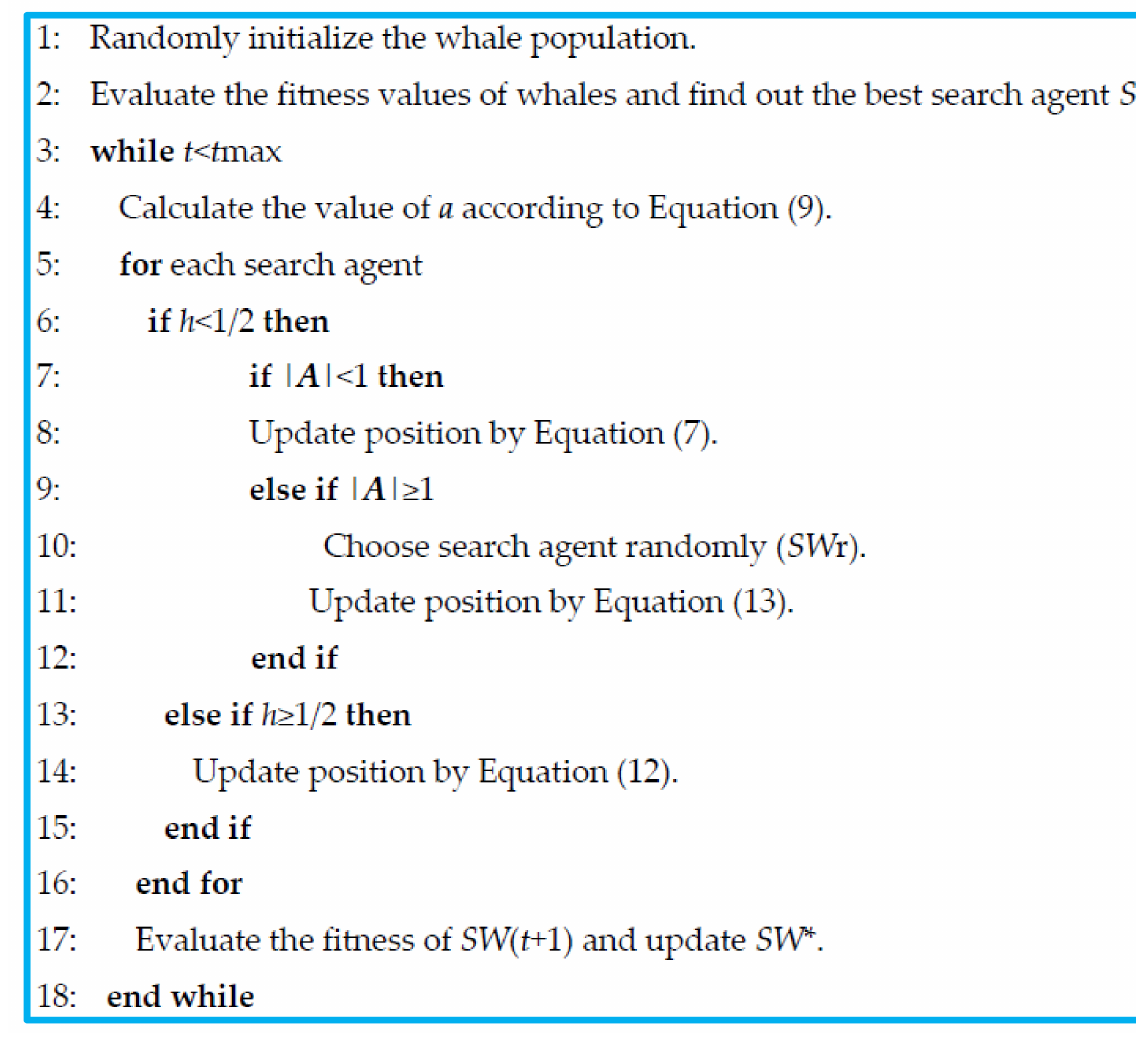
Figure 1. The developed code of whale optimization algorithm